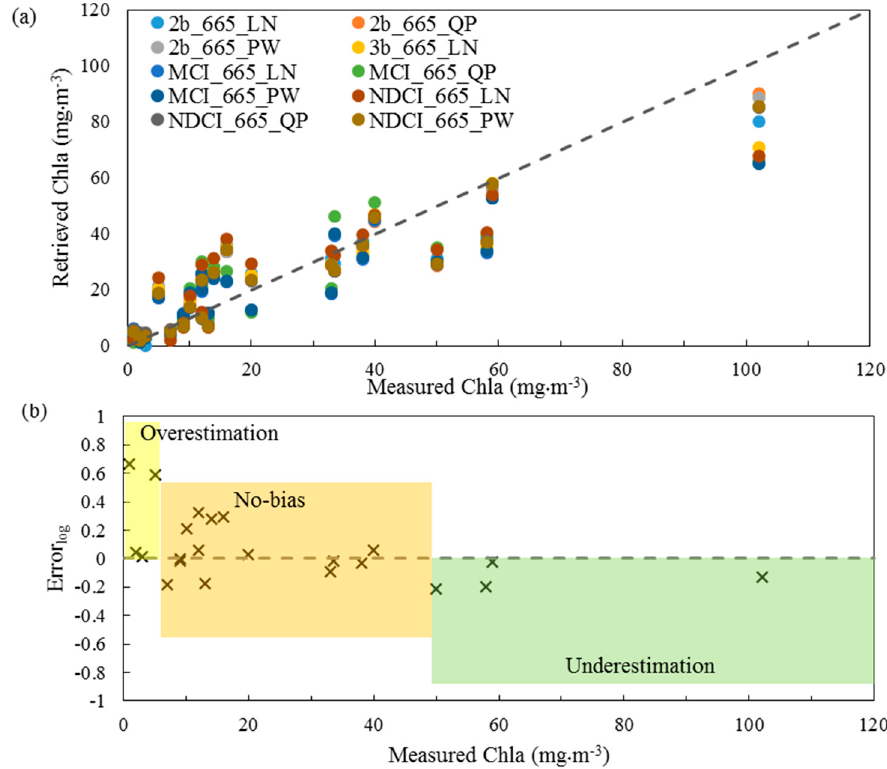
Figure 10. Assessment of the ten best algorithms of the in-situ dataset: ( a ) measured versus retrieved chlorophyll- a (Chla); and ( b ) errors versus the measured Chla, where the errors were estimated between the measured and mean retrieved Chla of the ten algorithms.